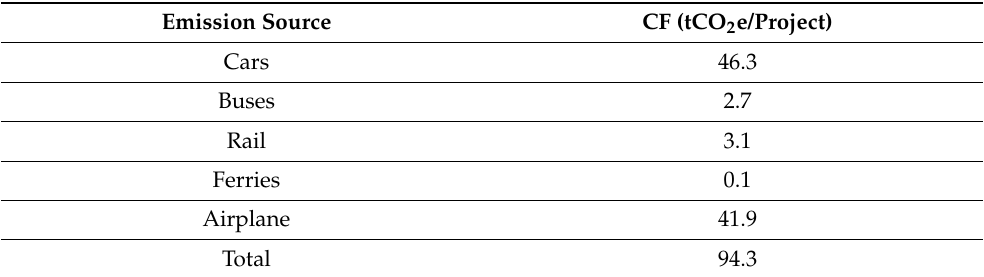
Table 5. Carbon Footprint (in tCO 2 e/project) of the arriving at or departing from the hosting city of on-site events organized by the project for the base case